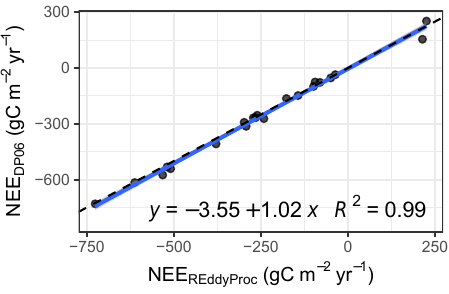
y = - 3.55 + 1.02 x R 2 = 0.99